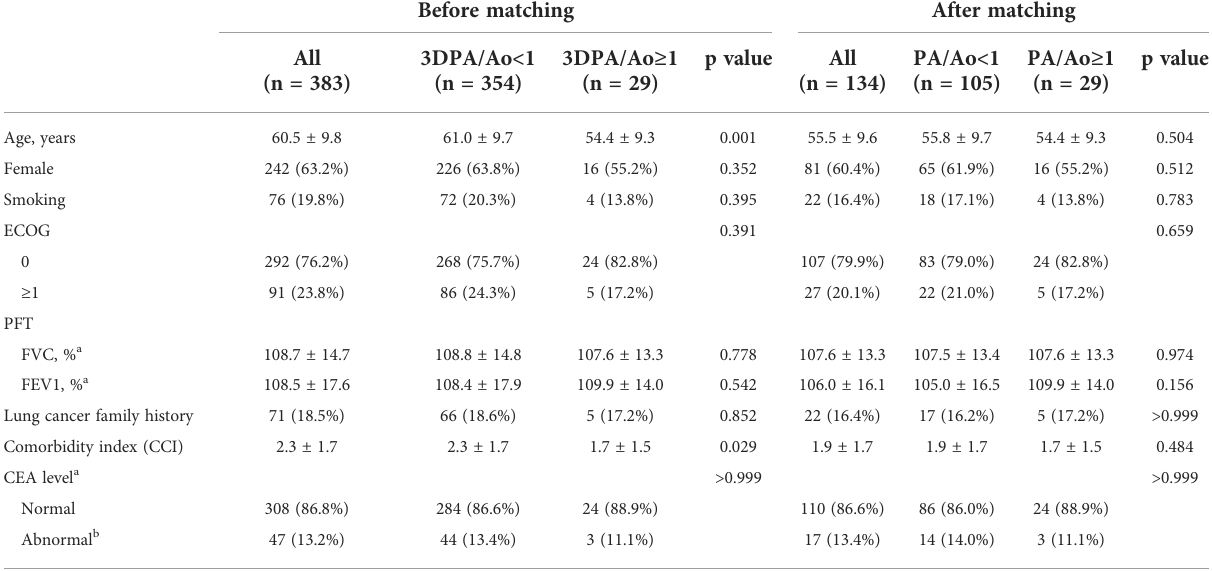
TABLE 1 Demographic and clinical features of lung cancer patients undergoing